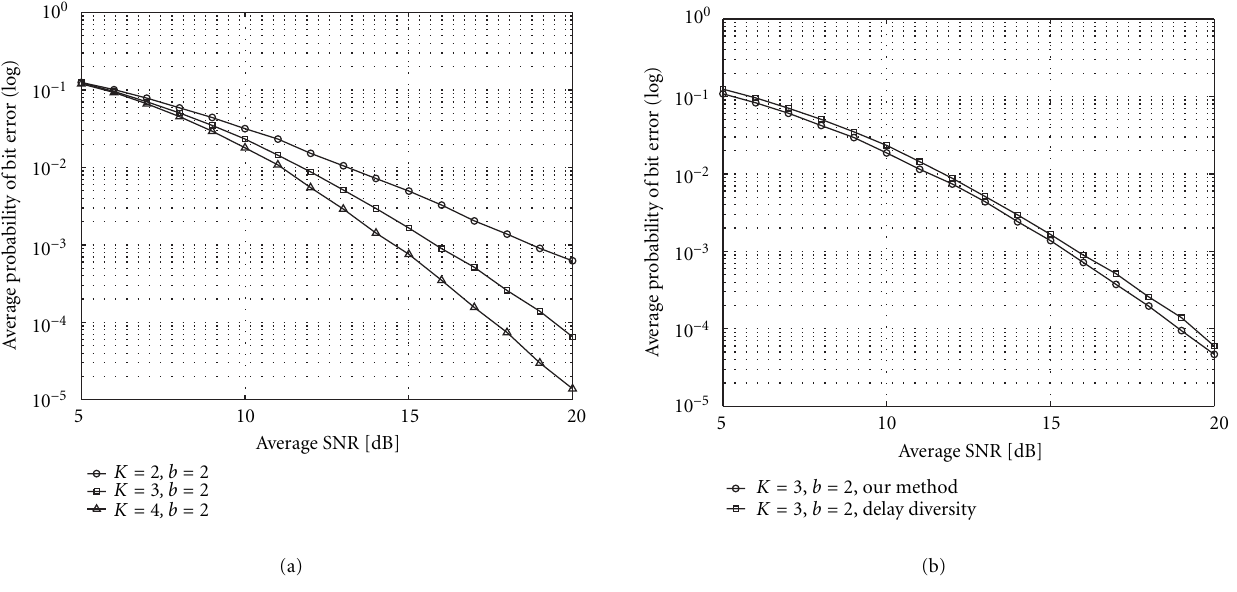
Figure 5: Simulation results I. (a) Delay diversity with QPSK, (b) three transmit antennas with QPSK.